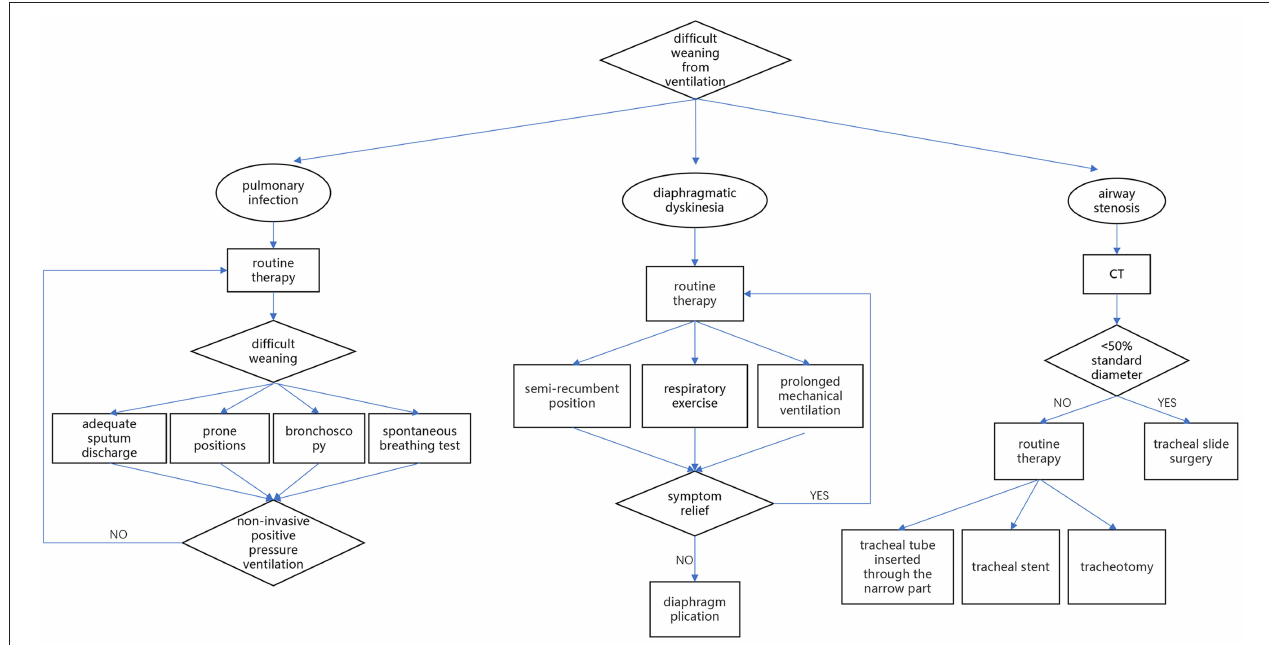
FIGURE 6 | The flow chart of the three strategies adopted in the three situations.